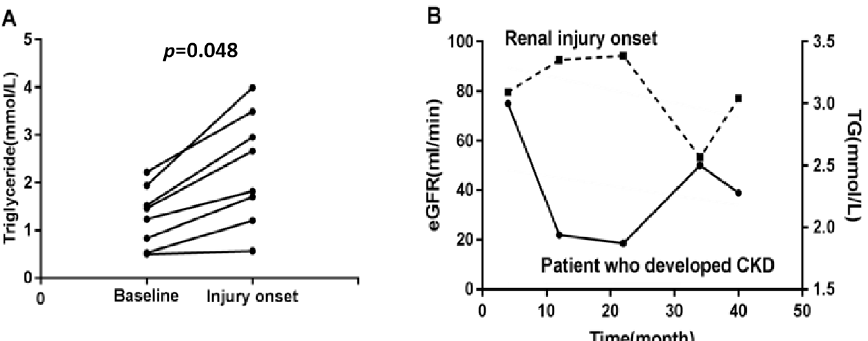
Figure 4. SLE patients with different levels of serum triglycerides experience different outcomes.